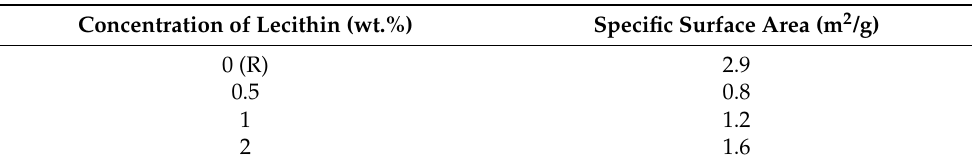
Table 9. Specific surface area for chemically crosslinked PVA-chitosan xerogels with different lecithin content determined by gas